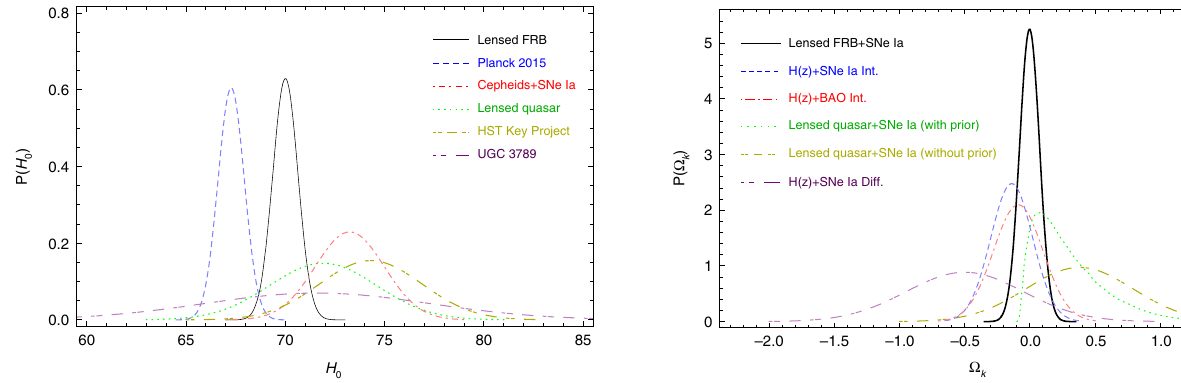
Fig. 1 Probability distribution functions (PDFs) of the Hubble constant Fig. 2 Model-independent probability distribution functions (PDFs) of the constrained from 10 lensed FRBs and some other currently available cosmic curvature estimated from 10 lensed FRBs and some other currently observations. Besides the result obtained from 10 lensed FRB systems in this available observations. Besides the result obtained from 10 lensed FRB work (the black solid line), from top to bottom the lines represent H 0 inferred systems in this work (the black solid line), from top to bottom the lines are Ω k from the Planck satellite CMB measurements (67.27±0.66kms − 1 Mpc − 1 ) 20 , inferred from the integral method with expansion rate (i.e., the Hubble local distance measurements (73.24±1.74kms − 1 Mpc − 1 ) 19 , time-delay parameter H ( z )) and SNe Ia observations ( − 0.140±0.161) 57 , the integral (cid:1) (cid:3) (cid:4) 1 Mpc (cid:4) 1 21 , distance cosmography of strongly lensed quasars 71 : 9 þ 2 : 4 (cid:4) method with expansion rate and BAO observations ( − 0.09±0.19) 58 , 3 : 0 kms measurements from the Hubble Space Telescope (HST) key project (74.3± distance sum rule with the prior Ω k > (cid:4) 0 : 1 0 : 25 þ 0 : 72 (cid:4) 0 : 33 2.6kms − 1 Mpc − 1 ) 55 , and VLBI observations of water masers orbiting within the accretion disc of UCG 3789 (71.6±5.7kms − 1 Mpc − 1 ) 56 , respectively